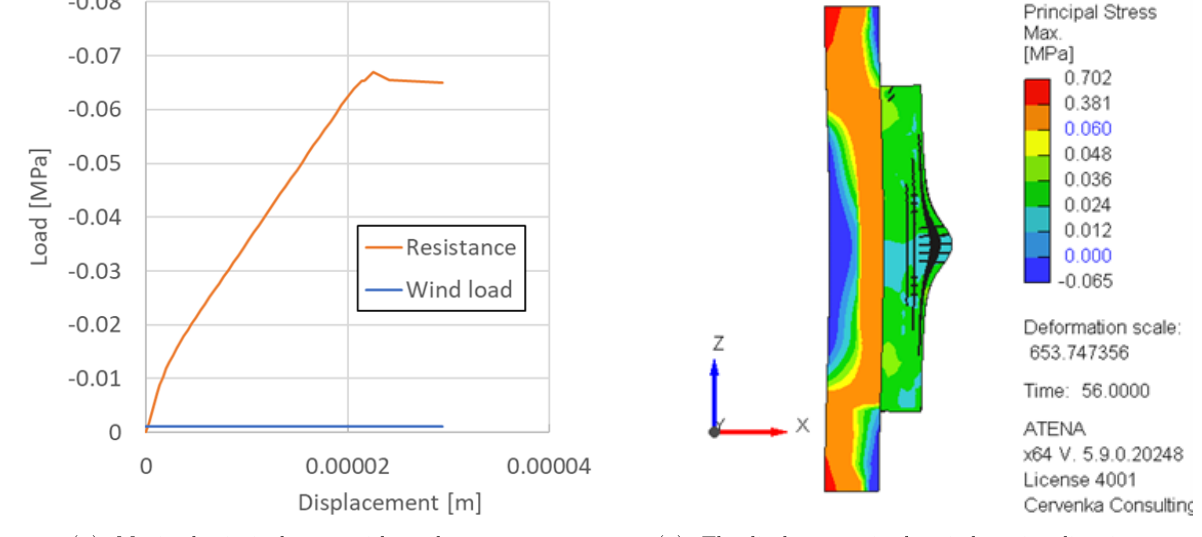
Figure 10. Structure response to wind